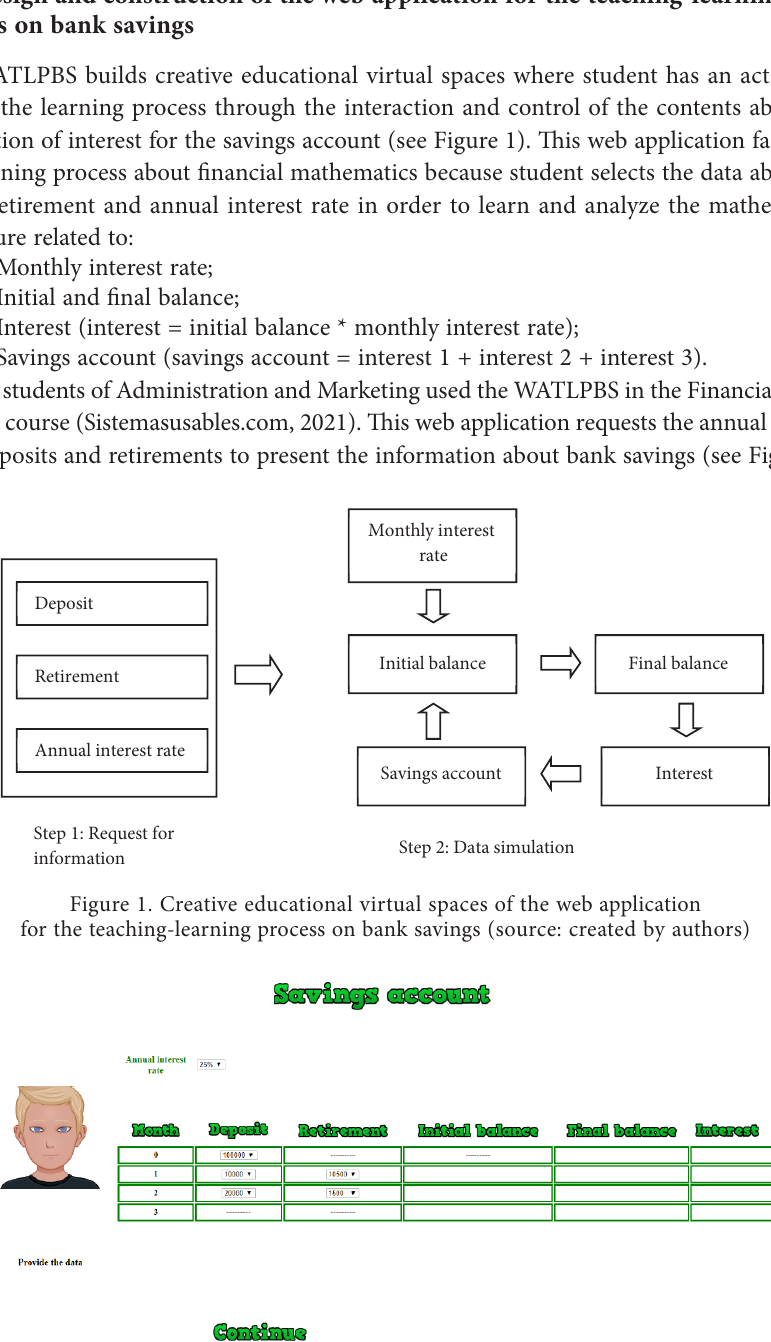
Figure 2. Homepage of the web application for the teaching-learning process on bank savings (source: created by